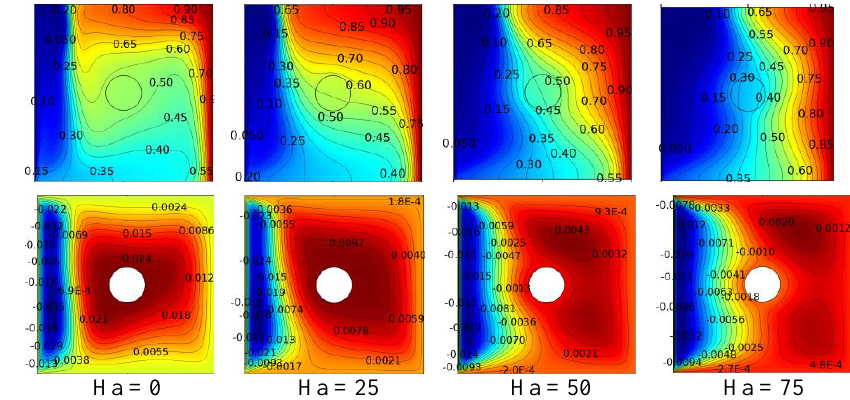
Fig. 7.isotherms (a) and Streamlines(b) for different values of Ha, with Ri = 3, φ =